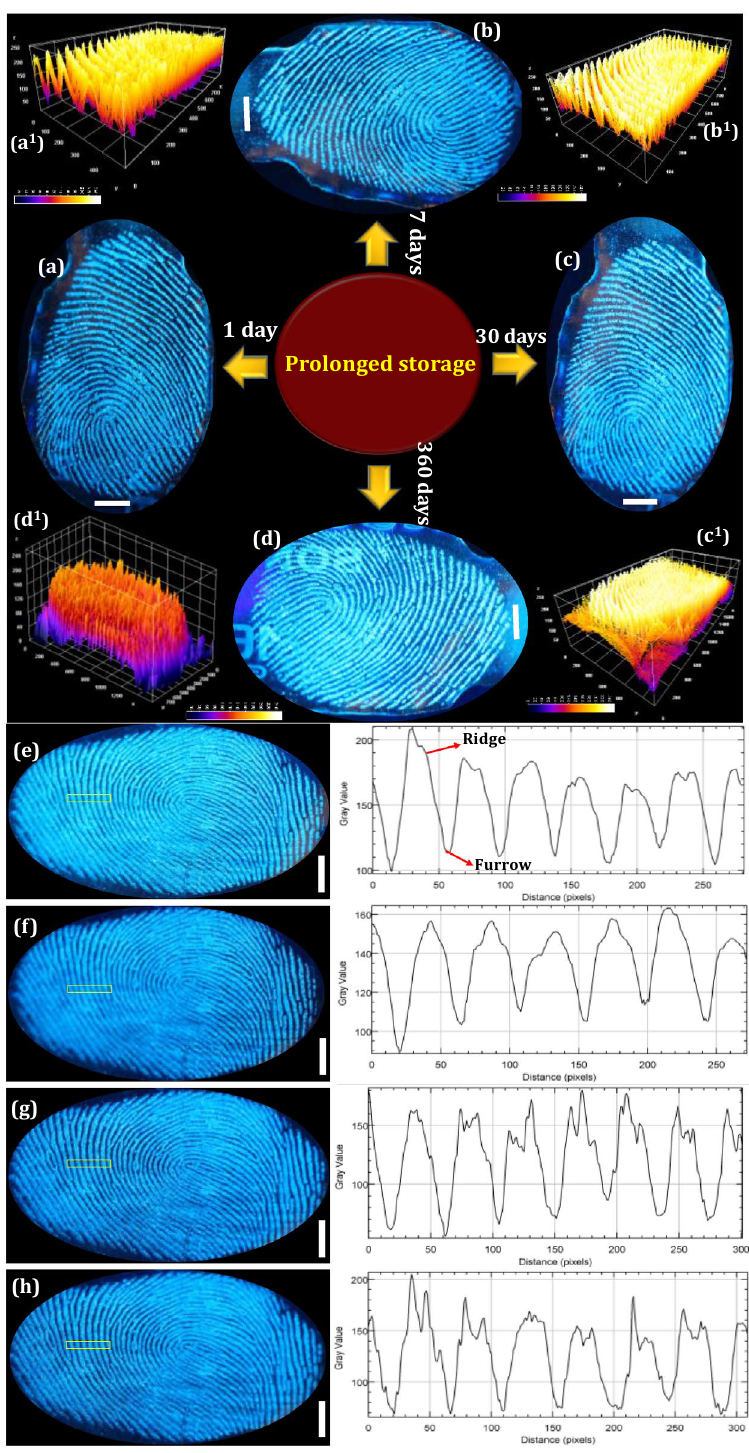
Figure 4. Fluorescence photographs of FP films developed using FDIP solution on glass surface and stored for ( a ) 1 day, ( b ) 7 days, ( c ) 30 days, ( d ) 360 days (The FPs are from the same finger); ( a 1 –d 1 ) 3-dimensional interactive plots of the corresponding FP ( a–d ) (showing uniform distribution of the prepared solution over the ridges); ( e–h ) fluorescence images of donor fingers impressed on the surface of the glass substrate and subsequently aged for 1, 7, 30 and 90 days. The corresponding gray scale profiles of each images of ( e–h ), display fluctuations of the gray values between FP ridge and furrow across the yellow line (Scale bar: 5